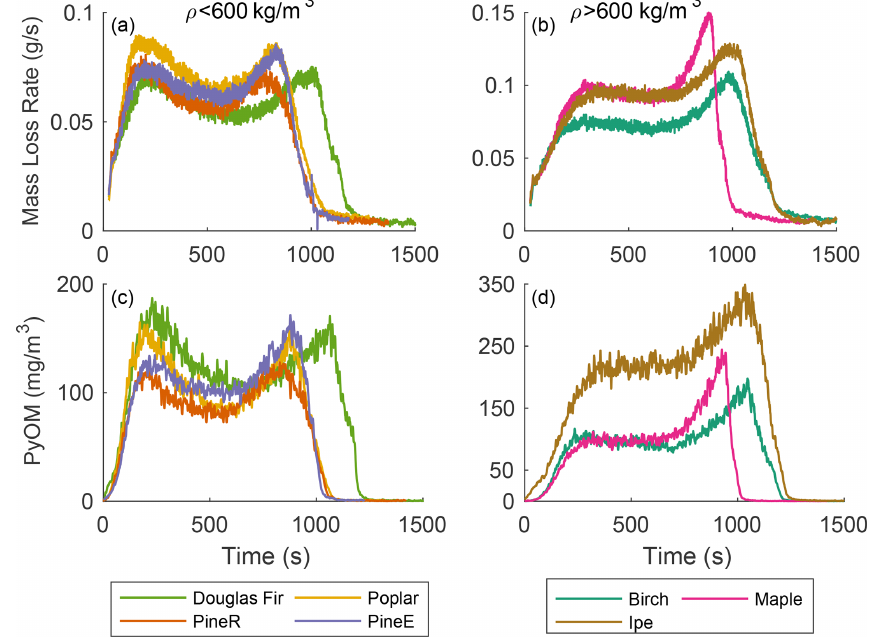
Figure 4. (a, c) Mass loss rate and real-time mass concentration of PyOM for low-density wood ( ρ < 600kgm − 3 ) and (b, d) high-density wood ( ρ > 600kgm − 3 ) at a reactor temperature of 500 ◦